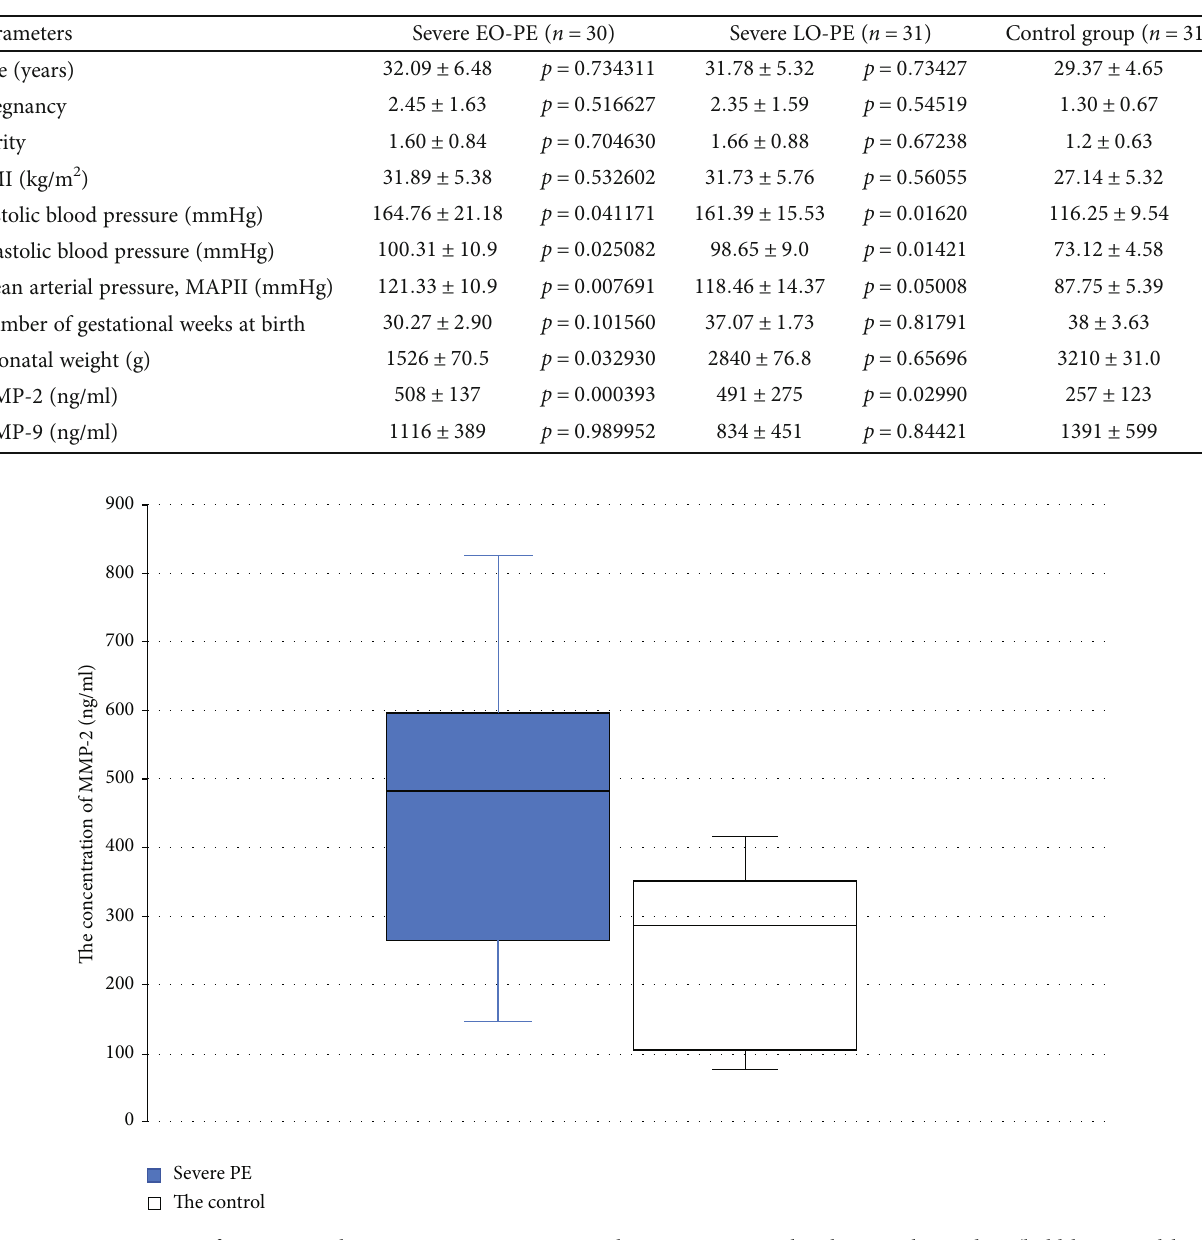
Figure 1: Concentration of MMP-2 in the severe PE group vs. normal pregnancy. Box plot showing the median (bold horizontal line), interquartile range (box), and total range (whiskers).